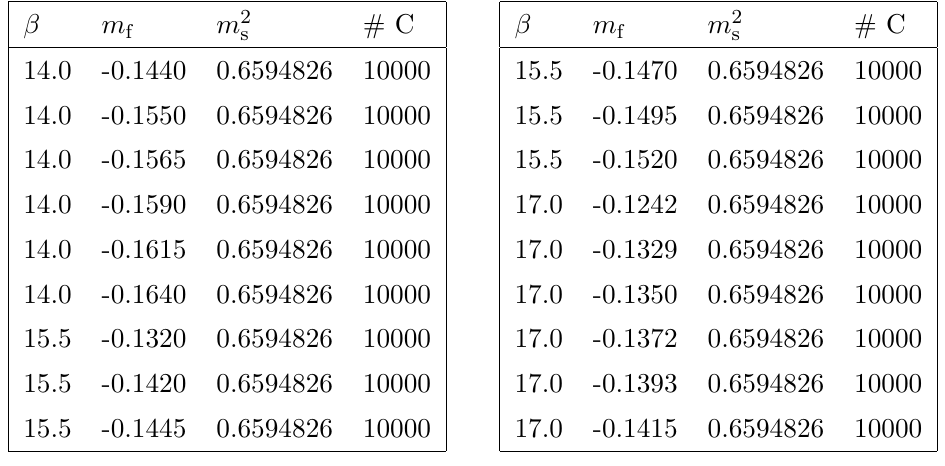
Table 6. Number of Con(cid:12)gurations (# C) for the given parameters (cid:12); m f and m s on a 64 (cid:2) 32